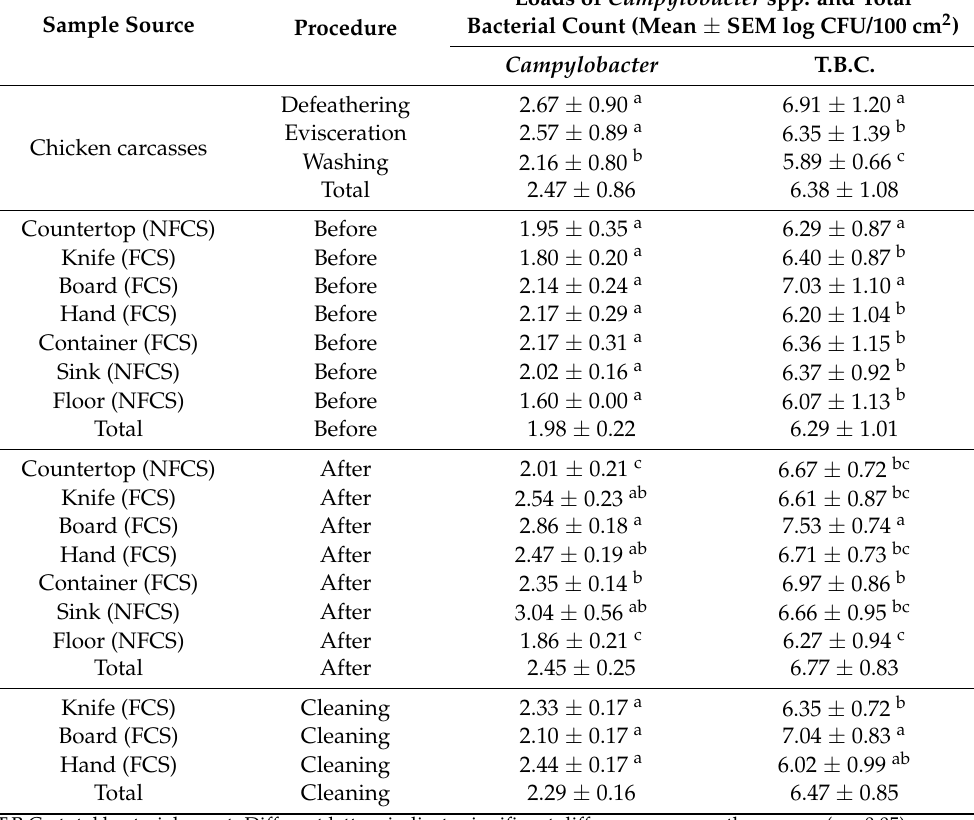
Table 3. Counts of Campylobacter spp. and total bacterial counts on chicken carcasses and sampling sites in commercial kitchens in